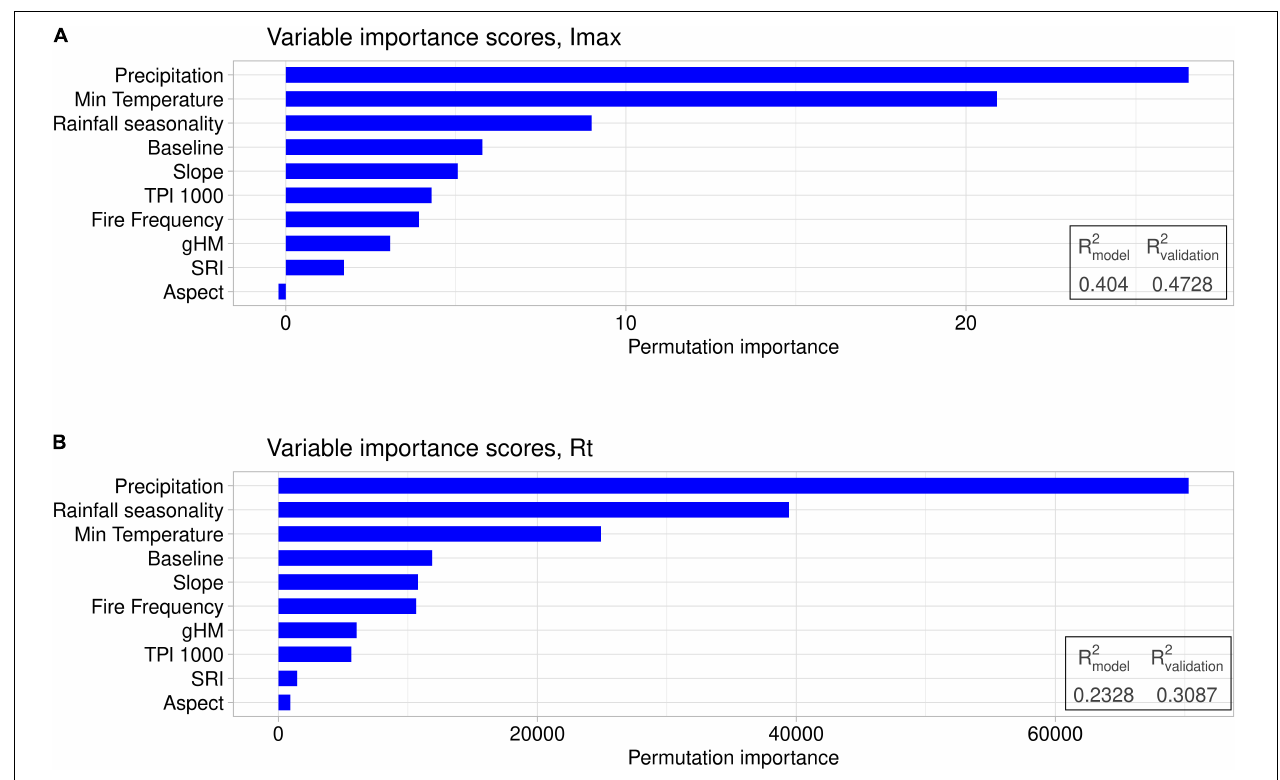
FIGURE 5 | Variable importance scores for the random forests with the maximum impact (Imax; A ) or the recovery time to the baseline (Rt; B ) as dependent variable. The predictor variables are indicated on the y-axis and are the same for each model. Importance scores are given as the permutation importance, which is the increase in mean squared error of the model when the values of a given predictor variable are randomly shuffled and the model run again. The importance scores are given in absolute terms rather than being normalized, and allow comparison between the relative predictive strengths of each